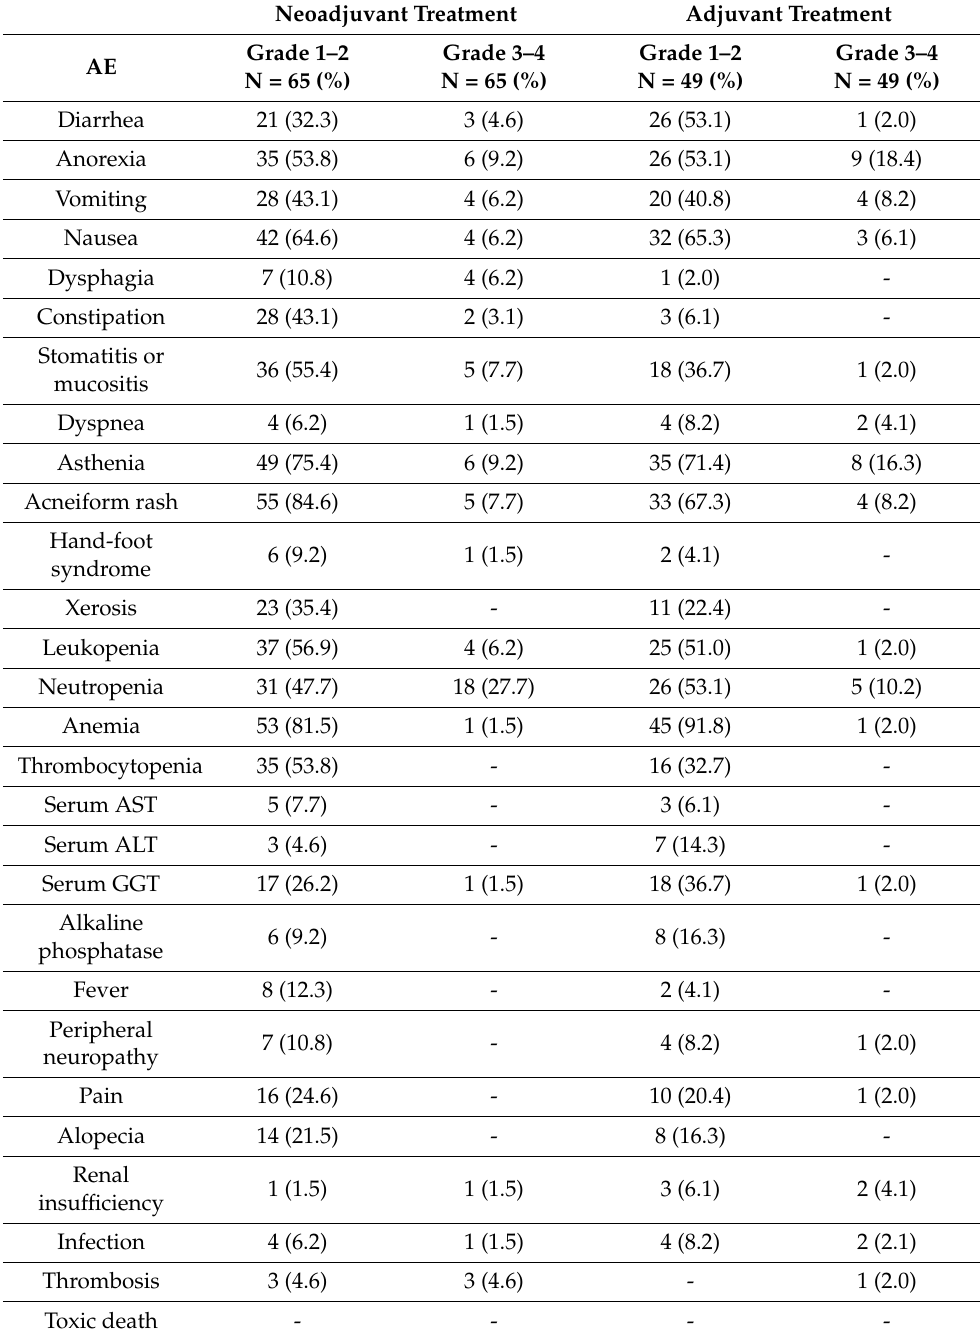
Table 2. Potential chemotherapy-associated adverse events during neoadjuvant and adjuvant treat-